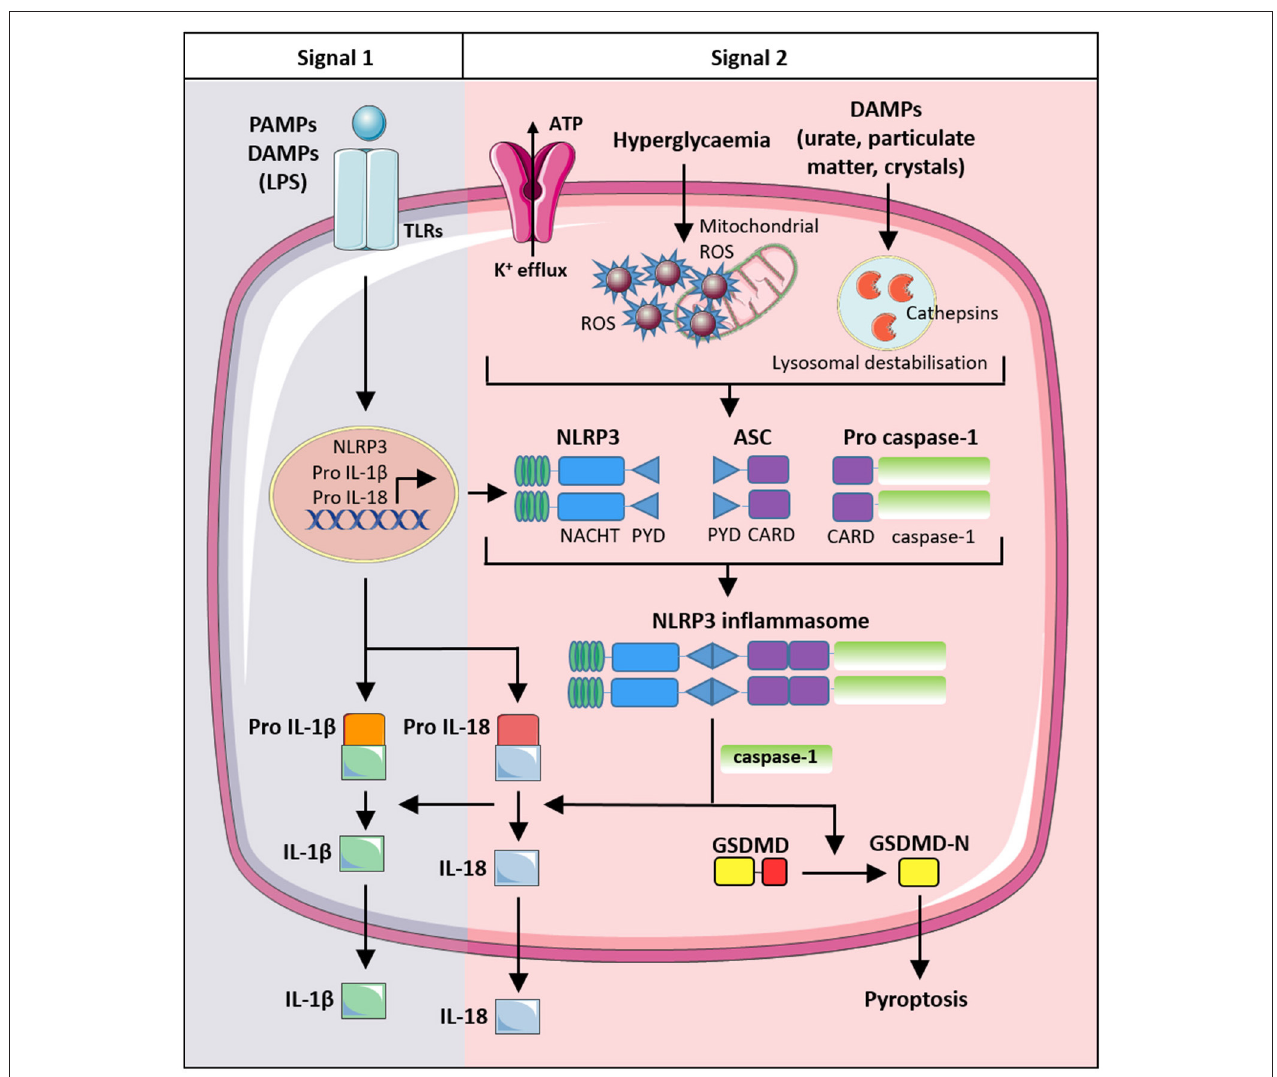
FIGURE 2 | A diagrammatic representation of NLRP3 inflammasome activation. NLRP3 activation is a distinct two-step process requiring a priming (“signal 1”) signal and an activating (“signal 2”) signal. The priming signal is usually initiated by PAMPs (LPS) that bind to toll-like receptors (TLR) and induce expression of NLRP3, pro IL-1 β , and pro IL-18. The second activating signal is required for NLRP3 inflammasome assembly, by binding of NLPR3 and pro caspase-1 to adaptor protein ASC. Activating signals include potassium efflux through ion channels and cathepsin release by lysosomal degradation. In settings of diabetes, excessive ROS production in the cytosol and mitochondria has been implicated in NLRP3 inflammasome activation. Following NLRP3 assembly and activation, caspase-1 undergoes proteolytic cleavage and further processes pro IL-1 β and pro IL-18 into their mature forms for secretion. In addition, caspase-1 also cleaves GSDMD which results in plasma membrane pore formation and pyroptototic cell death. PAMPs, pathogen associated molecular patterns; DAMPs, damage associated molecular patterns; LPS, lipopolysaccharides; ASC, apoptosis-associated speck-like protein containing a caspase recruitment domain (CARD); GSDMD, gasdermin D; CARD, caspase recruitment domain; PYD, PYRIN domain; NACHT, a domain containing NAIP, CIITA, HET-E and TEP1 domains.